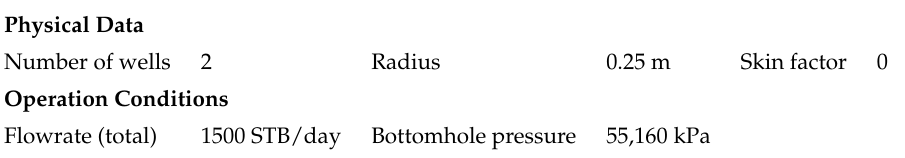
Table 3. Wells operating